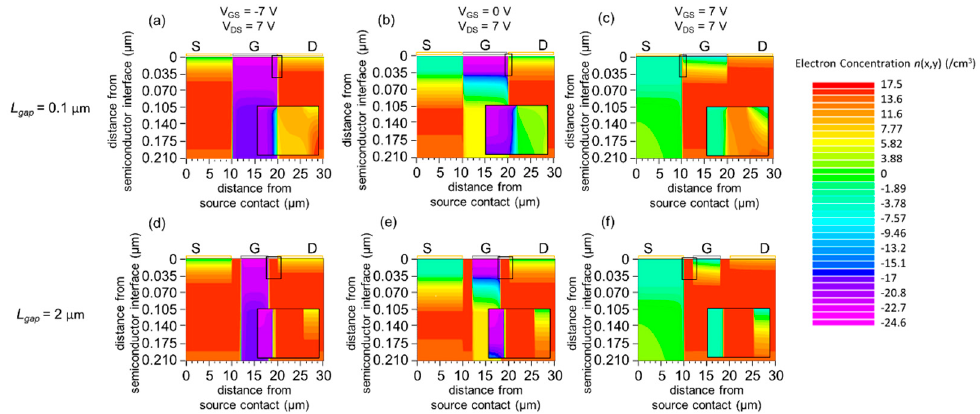
Figure 7. ( a – c ) Simulated carrier concentration distribution n ( x , y ) for L gap = 0.1 µ m ( a ) V GS = − 7 V and V DS = 7 V ( I G -dominant regime), ( b ) V GS = 0 V and V DS = 7 V (off regime), ( c ) V GS = 7 V and V DS = 7 V (normal-operation regime). ( d – f ) Simulated carrier concentration distribution n ( x , y ) for L gap = 2.0 µ m ( d ) V GS = − 7 V and V DS = 7 V ( I G -dominant regime), ( e ) V GS = 0 V and V DS = 7 V (off regime), ( f ) V GS = 7 V and V DS = 7 V (normal-operation regime). The entire semiconductor layer is shown for all panels ( a – f ). A magnified view of the semiconductor region near the gate electrode (19.8 µm ≤ x ≤ 20.1 µm for ( a , b ), 9.9 µm ≤ x ≤ 10.2 µm for ( c ), 17 µm ≤ x ≤ 21 µm for ( d , e ), 9 µm ≤ x ≤ 13 µm for ( f )) is shown for all panels. The work function of the gate is W G = 5.4 eV.